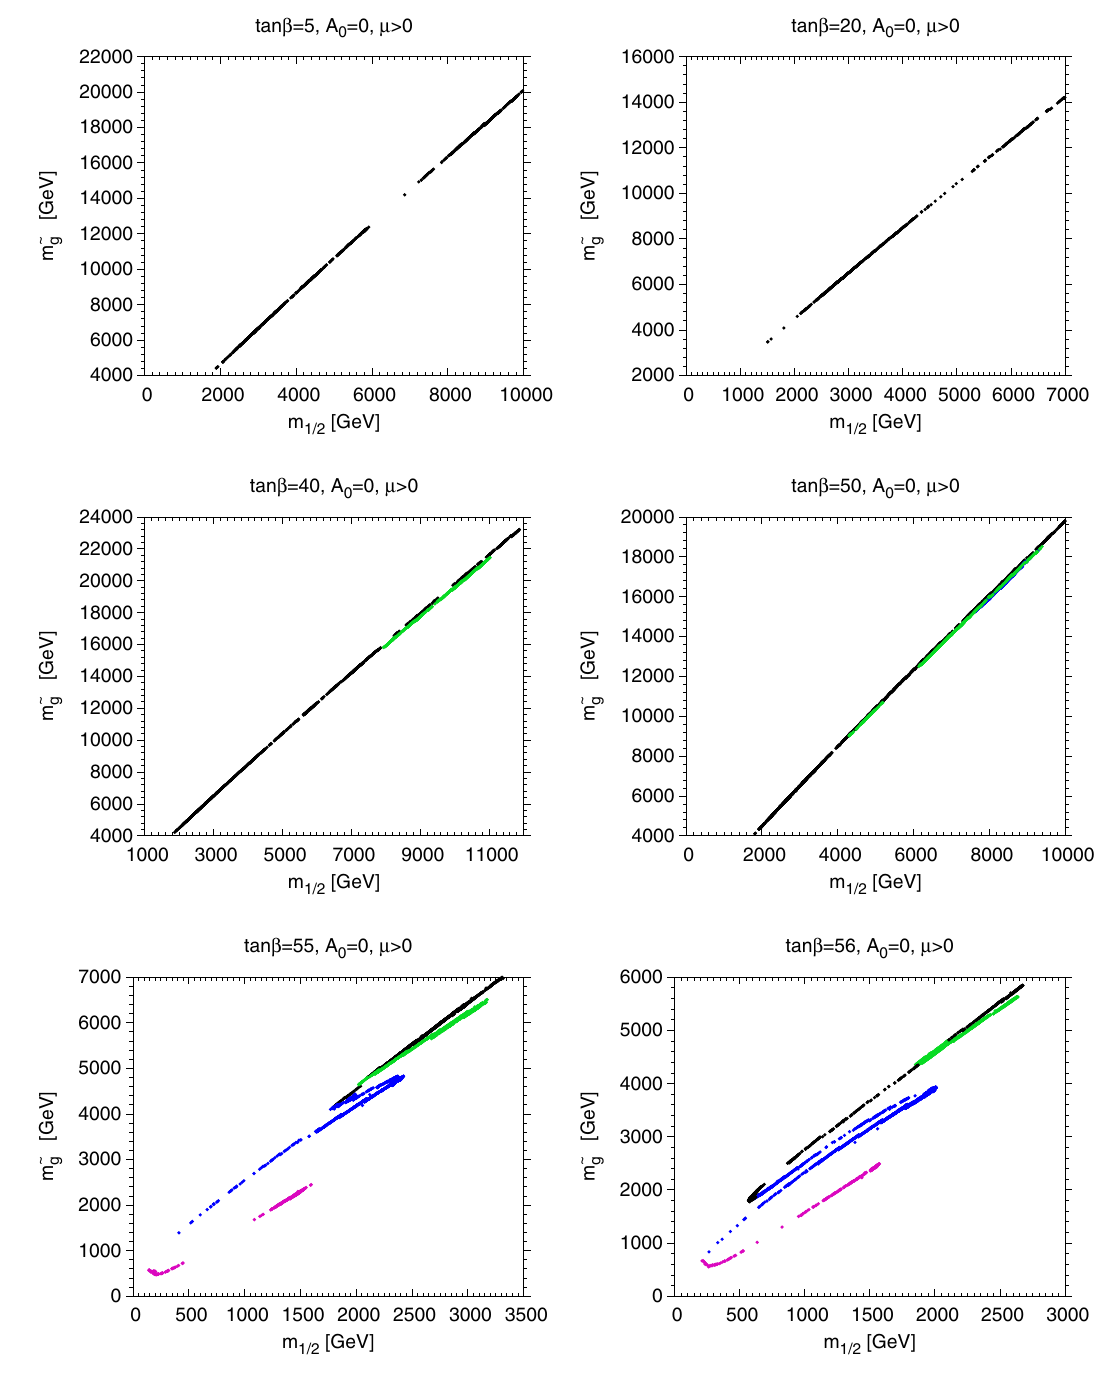
Fig. 7 The gluino mass along the dark matter strips for tan β = 5 , 20 , 40 , 50 , 55 and 56, with A 0 = 0 and μ > 0